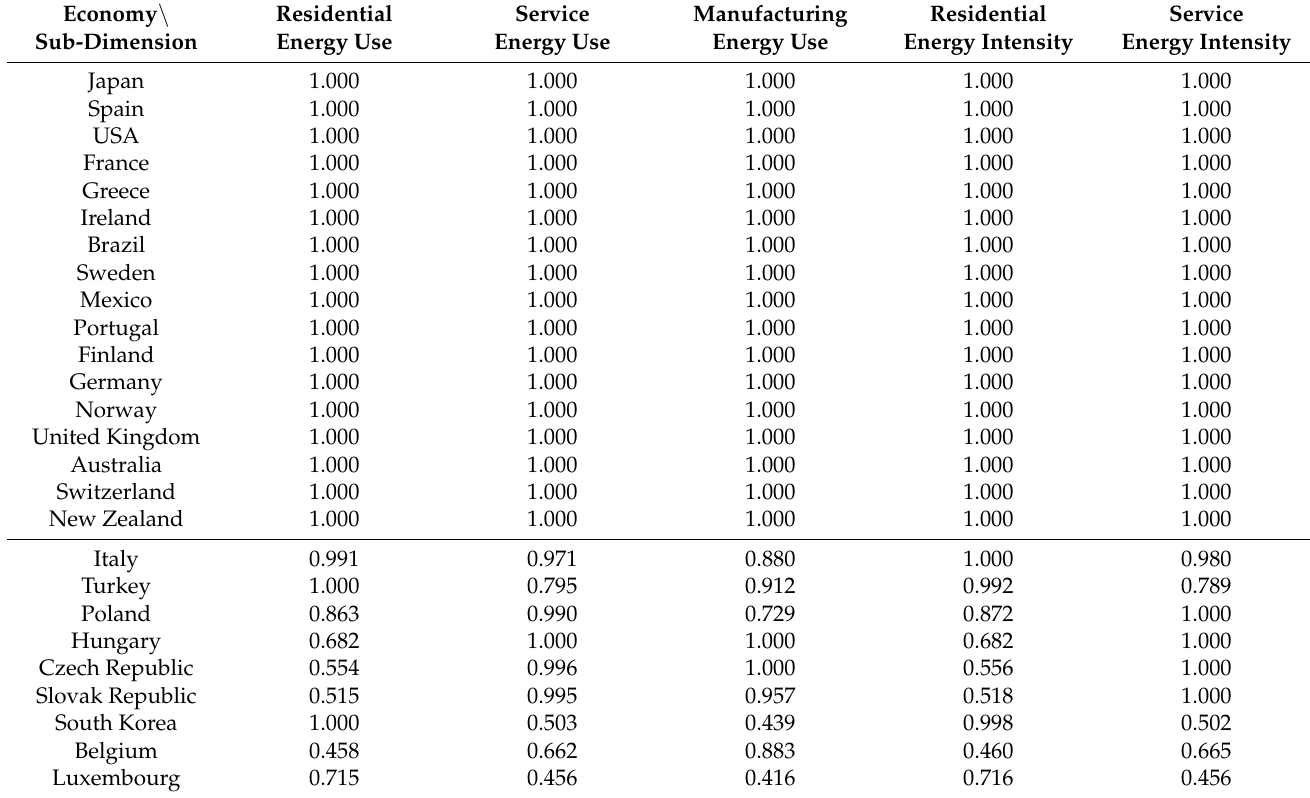
Table A3. Output efficiency in the economic